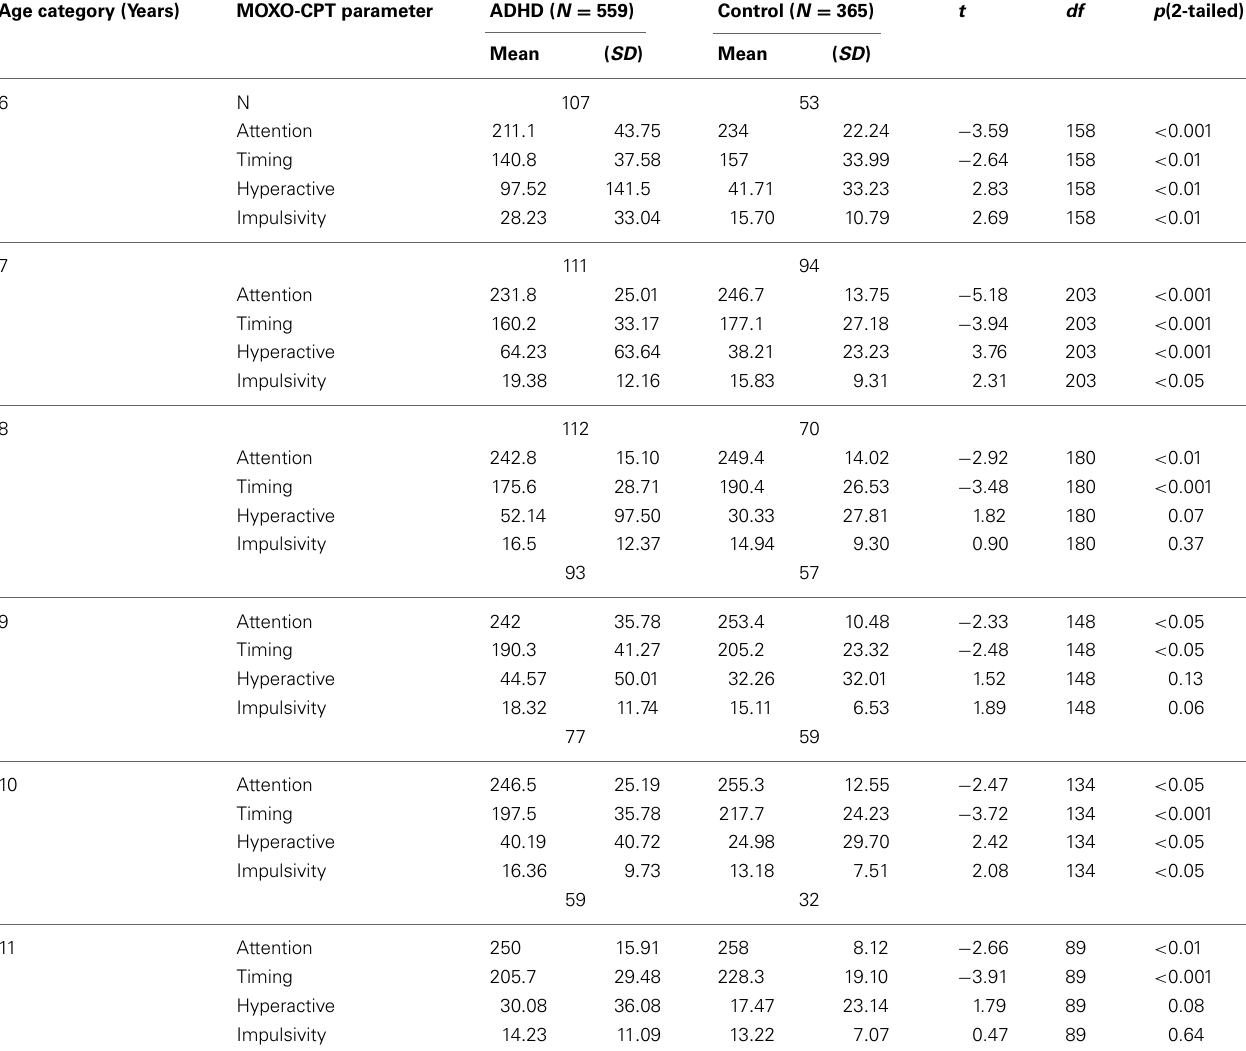
Table 2 | Differences between ADHD children and their typically developed peers in MOXO-CPT